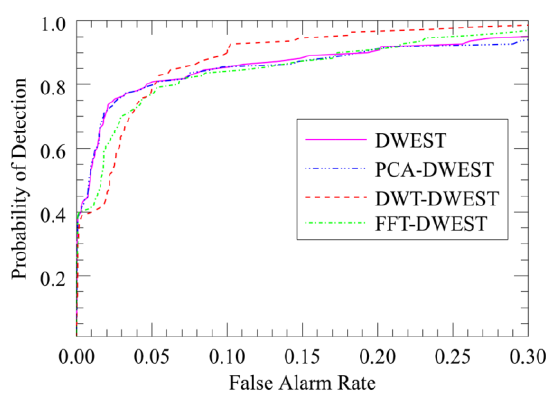
Figure 7. ROC curves of the Kernel-RX AD family for Img-I.